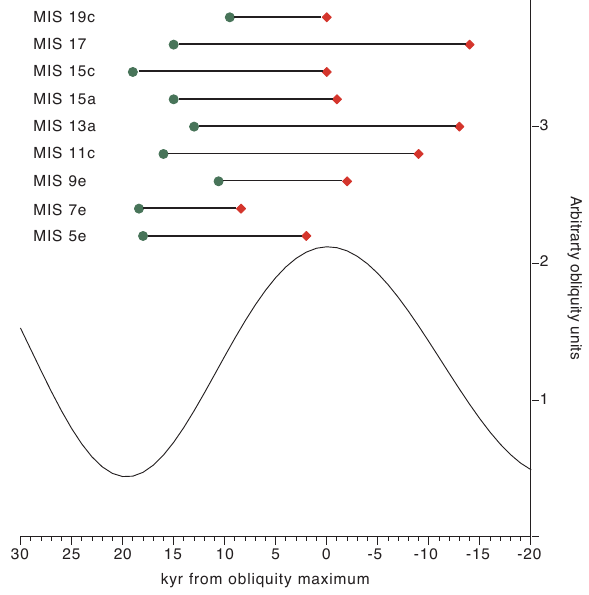
Fig. 6. Timing of the onset (diamonds) and end (circles) of inter- glacials in relation to an idealized obliquity